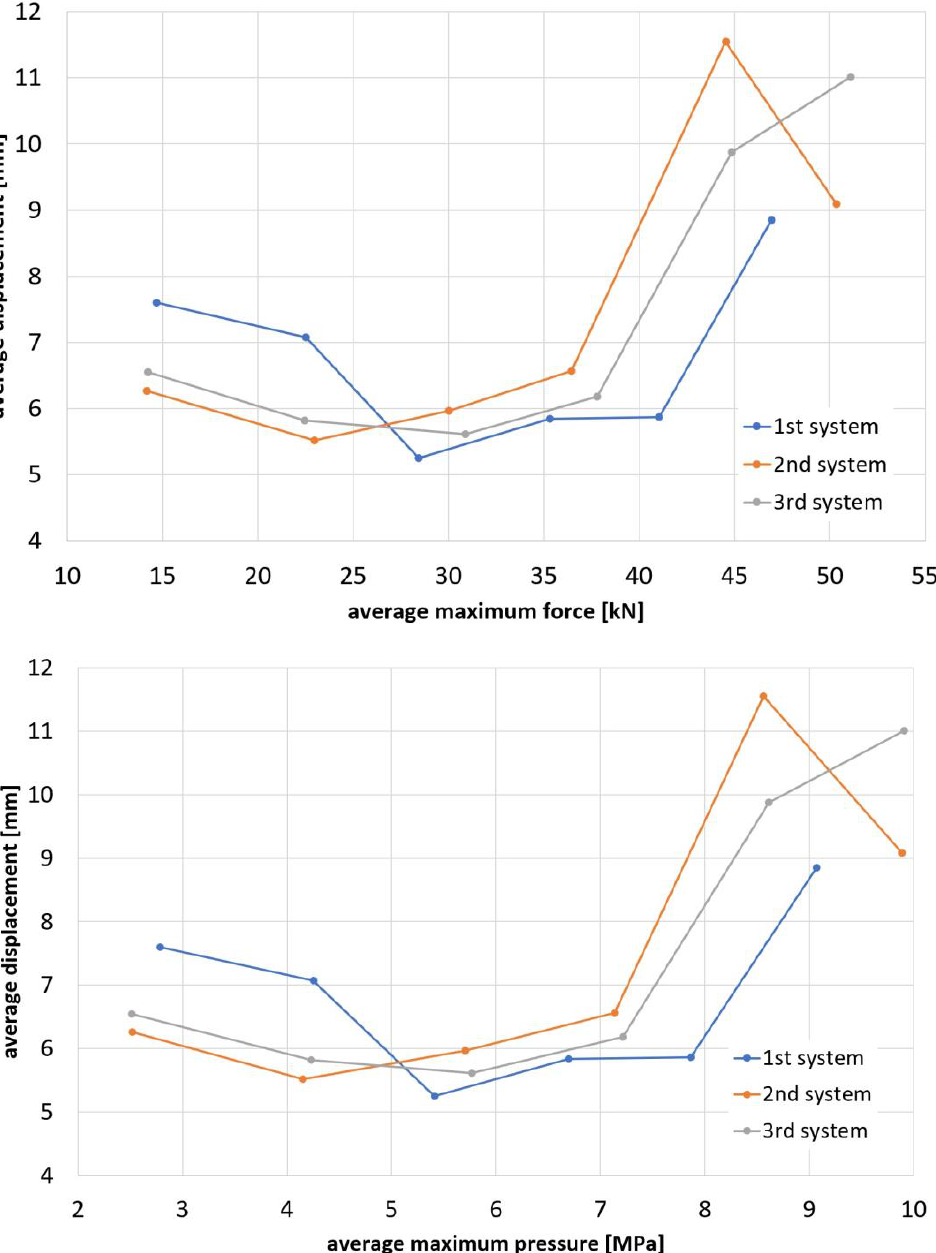
Figure 10. Average cylinder piston rod displacement values recorded after the initiation of the stopping process, expressed as a function of the maximum forces and pressure.